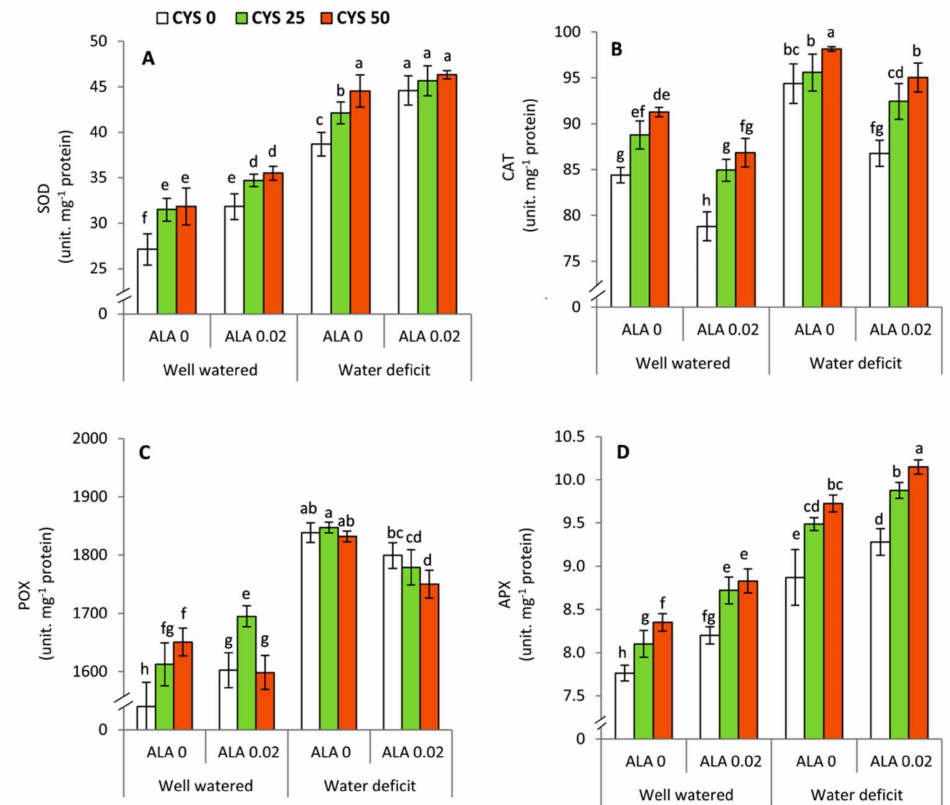
Figure 4. Effect of irrigation level, seed soaking by α -lipoic acid (ALA; 0 and 0.02 mM) and foliar application by cysteine (Cys; 0, 25 and 50 ppm) on the activities of antioxidant enzymes in wheat plants. ( A ) SOD, ( B ) CAT, ( C ) POX, ( D ) APX. For each parameter, the mean values ± SD followed by a different letter are significantly different according to Tukey’s range test ( p ≤